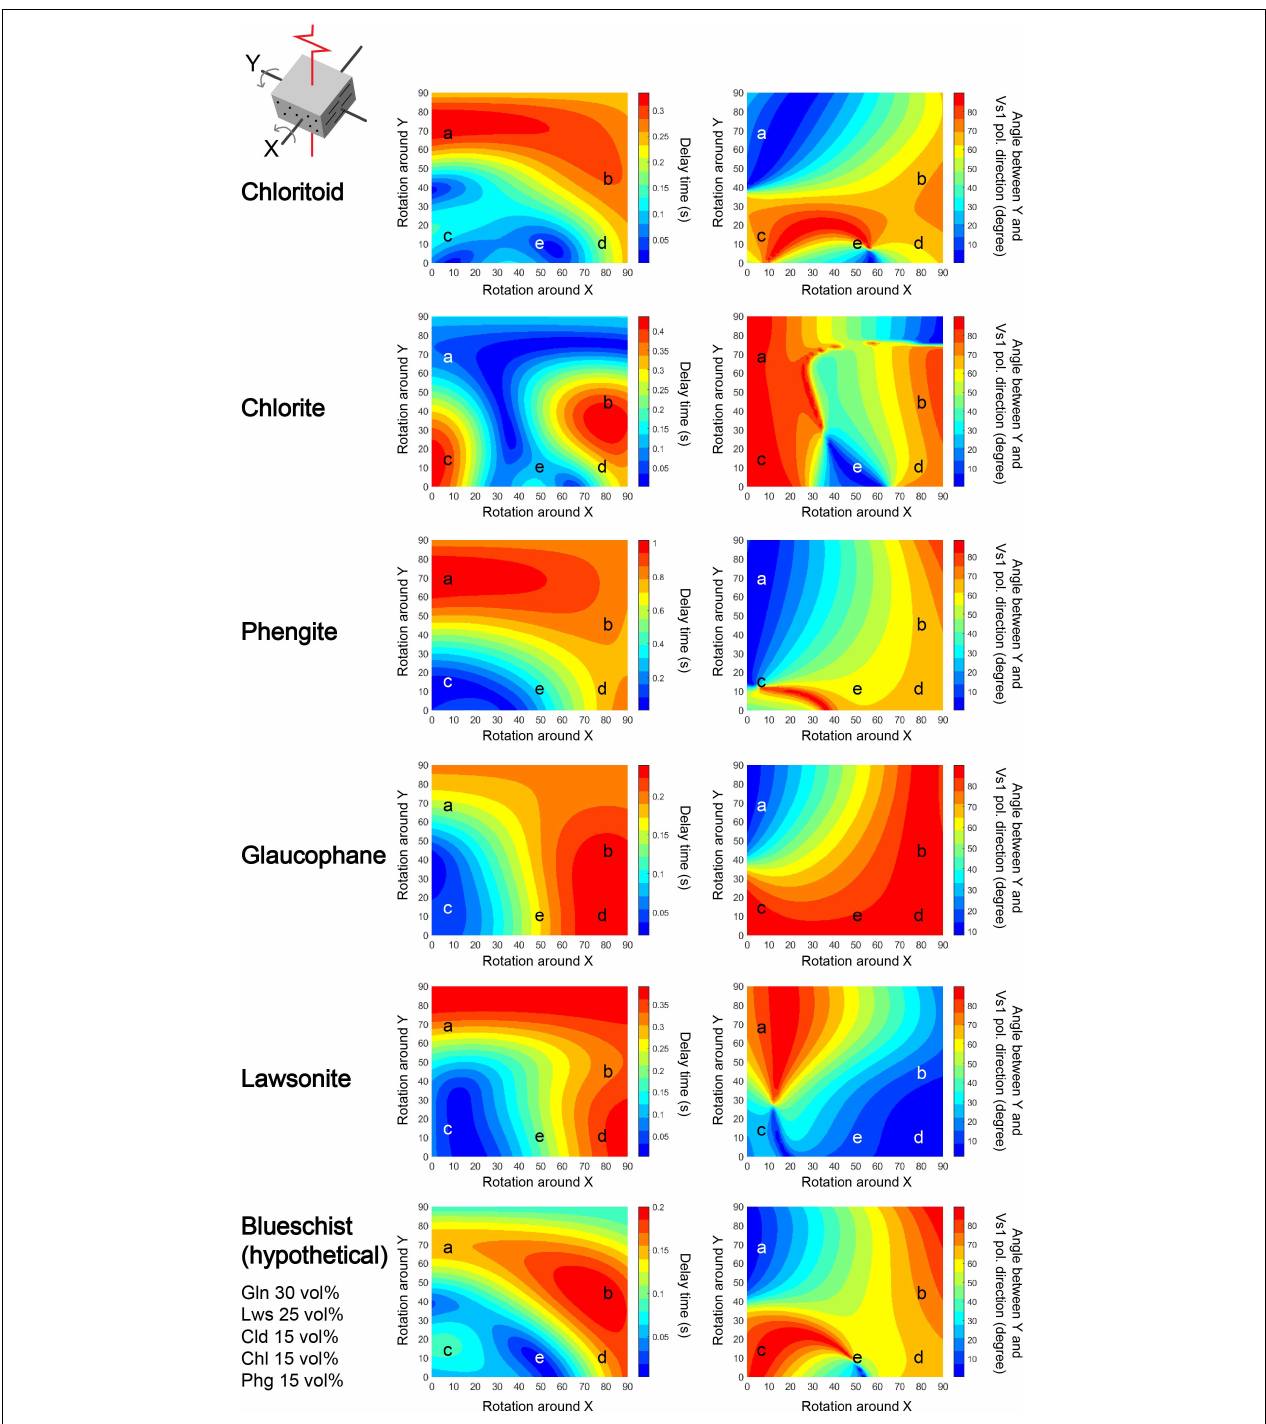
FIGURE 9 | Representation of the effect of the glaucophane, lawsonite, chlorite, phengite, and chloritoid on the delay time and fast S-wave polarization direction of a vertically incident S wave, and that of the bulk seismic anisotropy of a hypothetical blueschist, consisting of glaucophane (Gln):lawsonite (Lws):chlorite (Chl):phengite (Phg):chloritoid (Cld) = 30:25:15:15:15 (vol.%). The LPO data of each polycrystalline mineral were obtained from previous studies on naturally deformed blueschists [glaucophane aggregate from Cao et al. (2013) and lawsonite aggregate from Choi et al. (in unpublished)] and this study (LPOs of chlorite, phengite, and chloritoid in sample #15R). An anisotropic layer thickness of 10 km was assumed for consistency. The reference frame for the rotation and the sample orientation (schematics in the upper left) is the same as in Figure 8 . Color ranges describe the same parameters as in Figure 8 for both delay time and fast polarization direction. Symbols marked with “a”–“e” indicate five different ray paths and sample